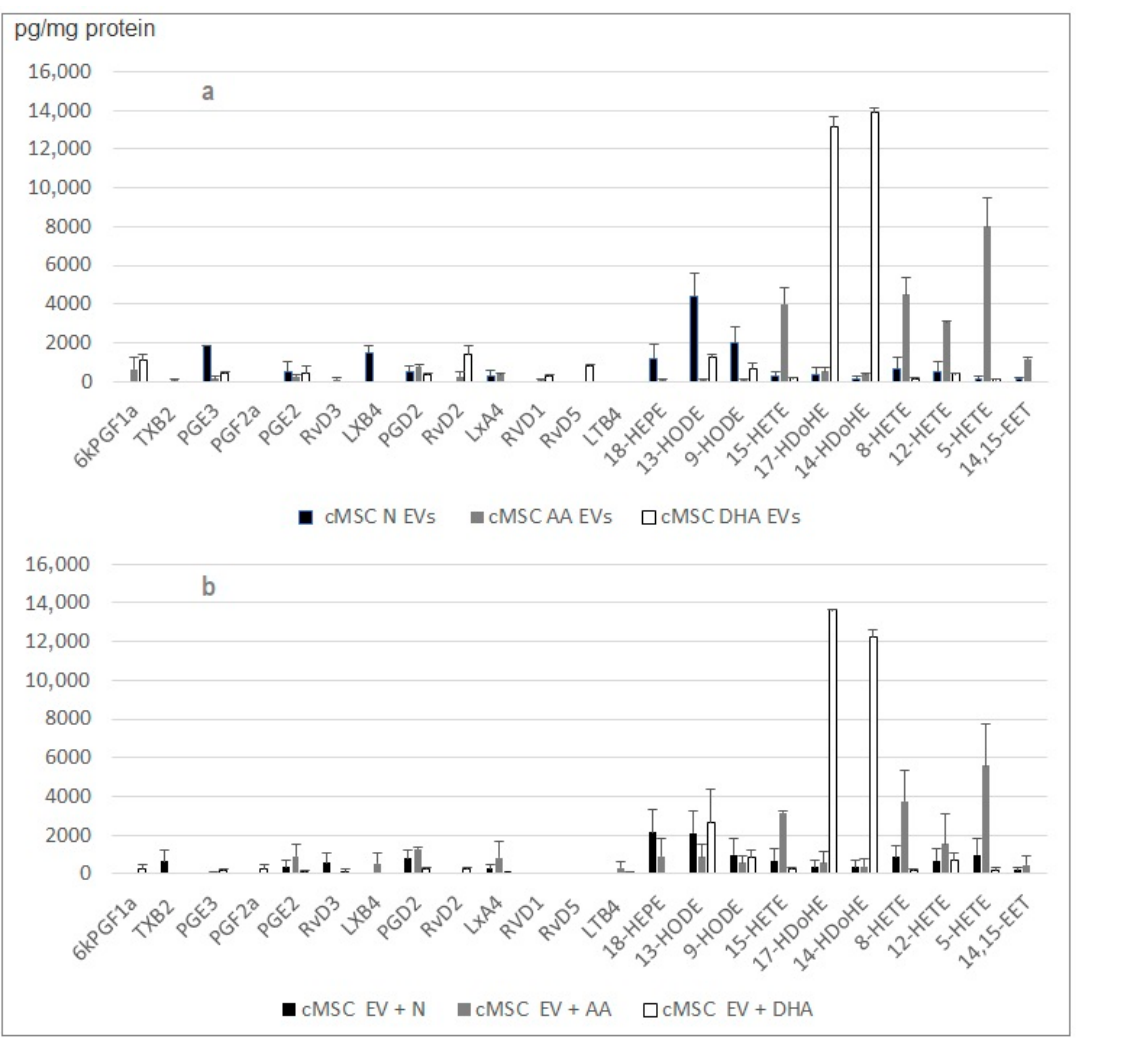
Figure 6. Comparison between the lipid mediator profiles embedded in ( a ) small EVs released by cMSC cultured in the presence of PUFAs and ( b ) small EVs released by cMSC cultured in MEM α 1% FBS that were incubated after collection in MEM α supplemented with PUFAs. No lipid mediators were detected in the absence of small EVs. Number or replicate was four.